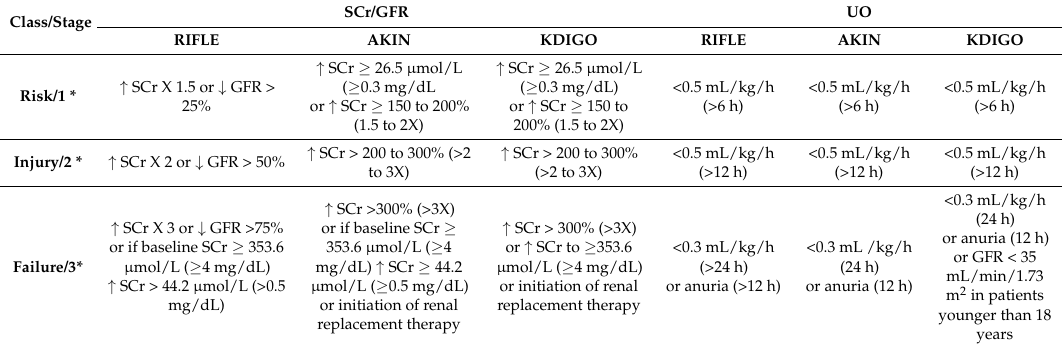
Table 1. Risk, Injury, Failure, Loss of kidney function, End-stage kidney disease (RIFLE) [22], Acute Kidney Injury Network (AKIN) [27], and Kidney Disease Improving Global Outcomes (KDIGO) [40]